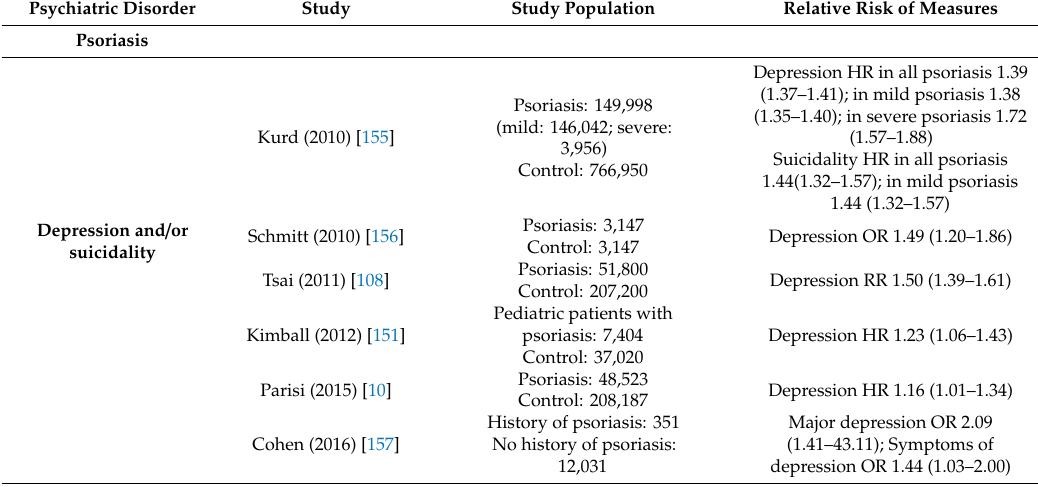
Table 6. Summary of recent (2010–2020) nationwide population-based cohort studies investigating the risk of psychiatric disorders in adult patients with psoriasis and psoriatic